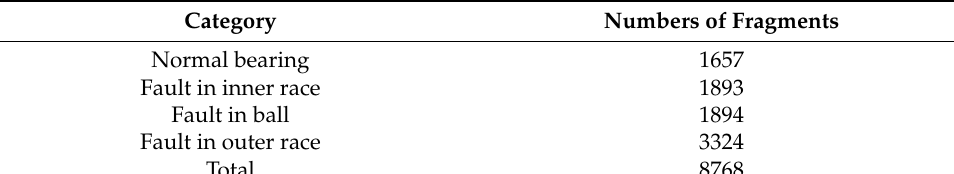
Figure 6. Data pre-processing procedure.